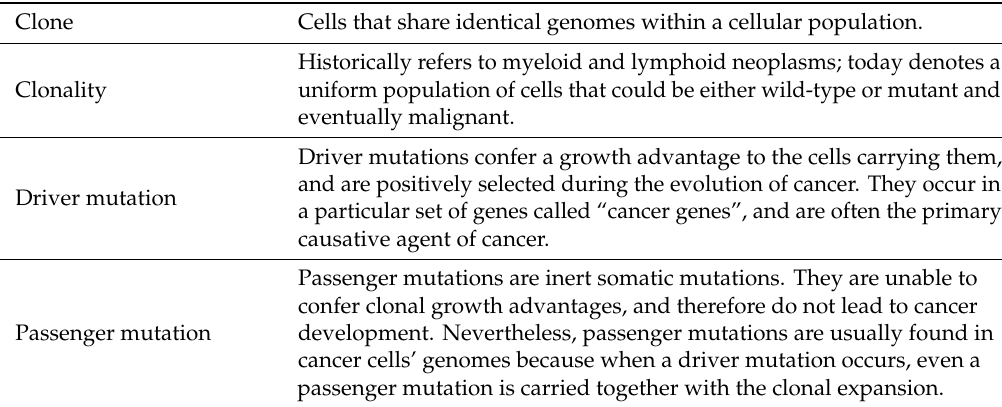
Table 1. Driver and passenger mutation, clone and clonality definitions [4,5].